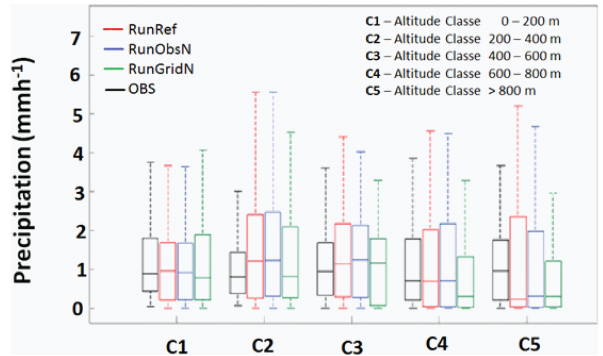
Fig. 7. Box plot for the observations (OBS; black boxes) and for the three experiments (RunRef, RunObsN and RunGridN) grouped by altitude – here represented by the C1 to C5 classes. The horizontal box line represents the median (50th percentile), the lower line the 25th percentile, and the upper line the 75th percentile. The dashed lines represent 1.5 times the